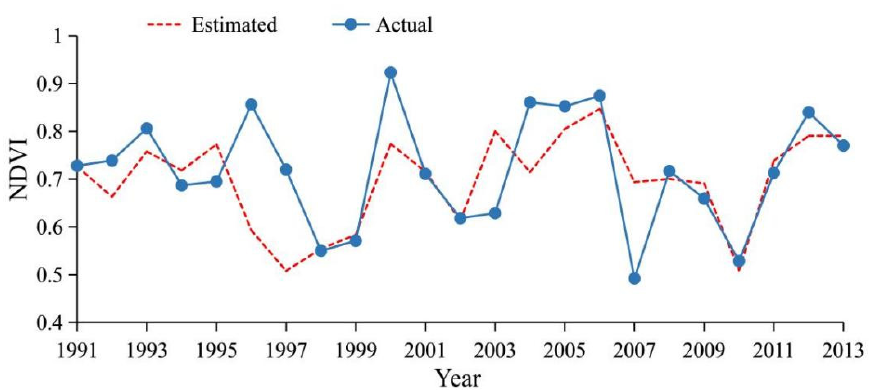
Figure 7. Comparison between the actual and estimated July NDVI during AD 1991–2013. Table 3. Leave ‐ one ‐ out cross validation statistics for the annual maximum NDVI reconstruction. Based on Equation (1), we recovered the annual maximum NDVI series at the Mt. Taibai timberline as far back as 146 years (Figure 8), where the smoothed line is an 11-year moving average to demonstrate the low-frequency features of the reconstructed series, and to better observe the decadal-scale variation [43].